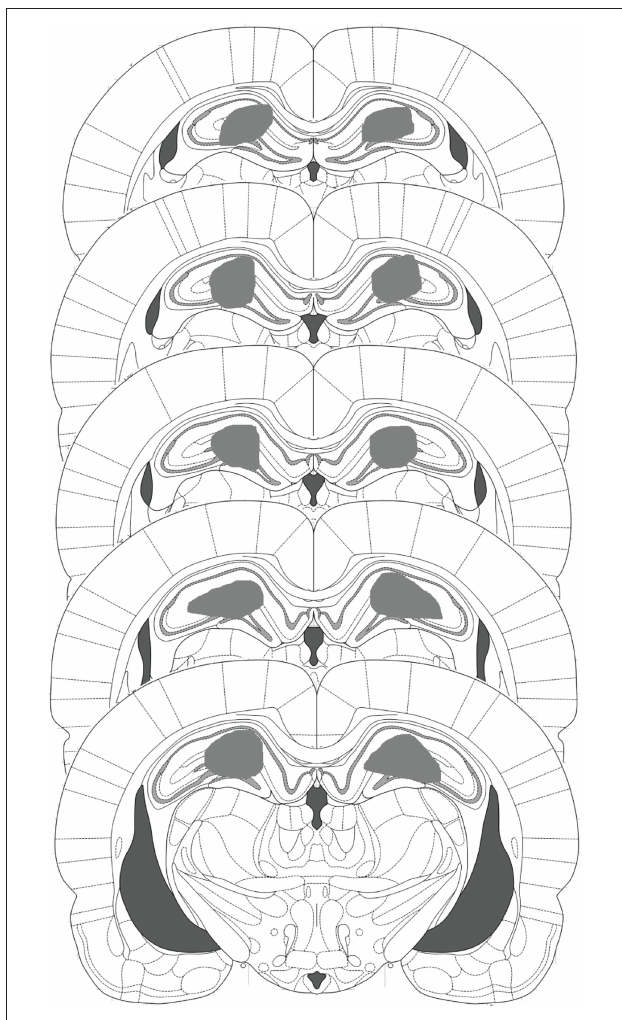
Figure 2 | Schematic representation of the locations of injectors within the dorsal hippocampus. All injector tips across the behavioral experiments were located within the gray shaded area.